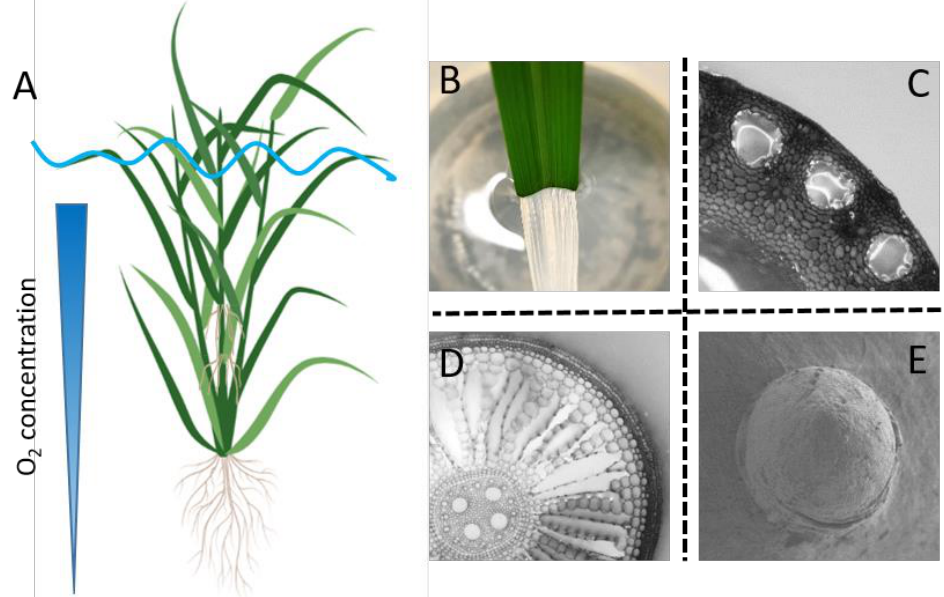
Figure 1. Rice adaptive traits during waterlogging. Rice develops a range of adaptive traits upon soil flooding including stem elongation ( A ), gas film retention by the superhydrophobic leaves ( B ), aerenchyma formation in the internodes of the stem ( C ) and in the cortex of the roots ( D ), and floating adventitious roots ( A , E ). Panel ( A ) is created with BioRender.com, and photos and cross-sections are all original contributions by the authors.